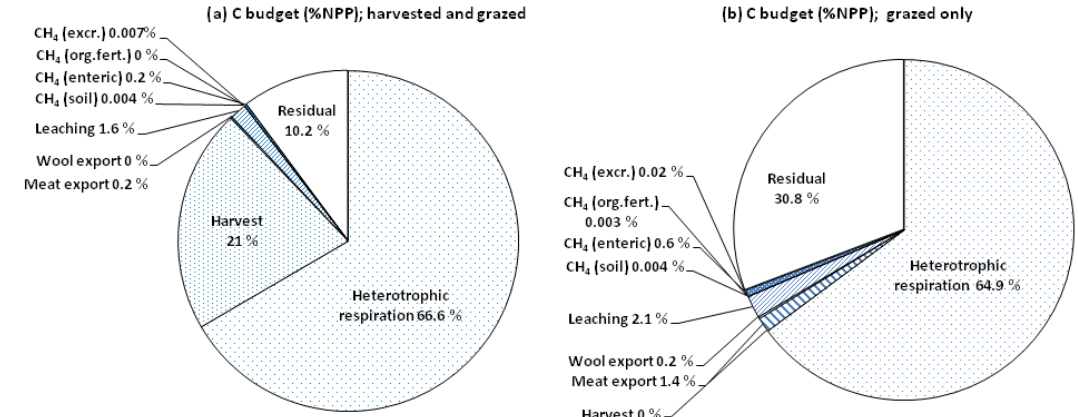
Figure 3. Mean annual carbon budget for Easter Bush, showing the fate of net primary productivity (NPP) in (a) years when grass was harvested for silage (2002 and 2003) and (b) in years when only grazing took place (2004–2010). Heterotrophic respiration includes the respiration of soil microbes, cows and sheep. The residual term includes all the error in the budget calculation, as well as any net accumulation of soil organic carbon.